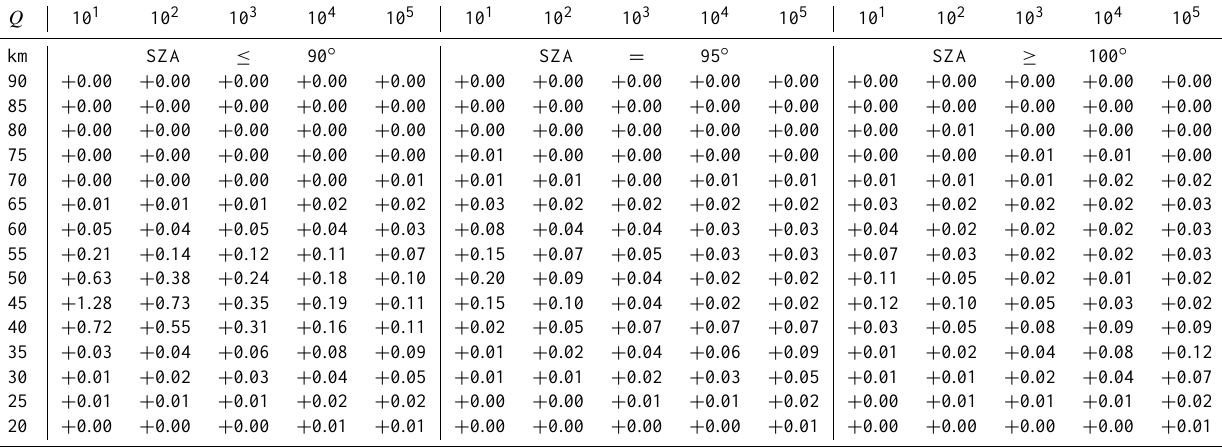
/Q for January NH. 3